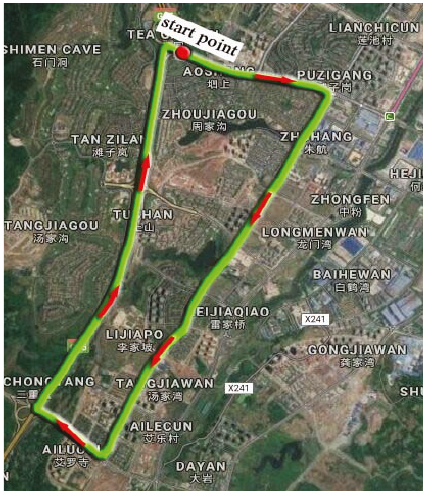
Figure 1: Diagram of the test route. Figure 2: Diagram of the field